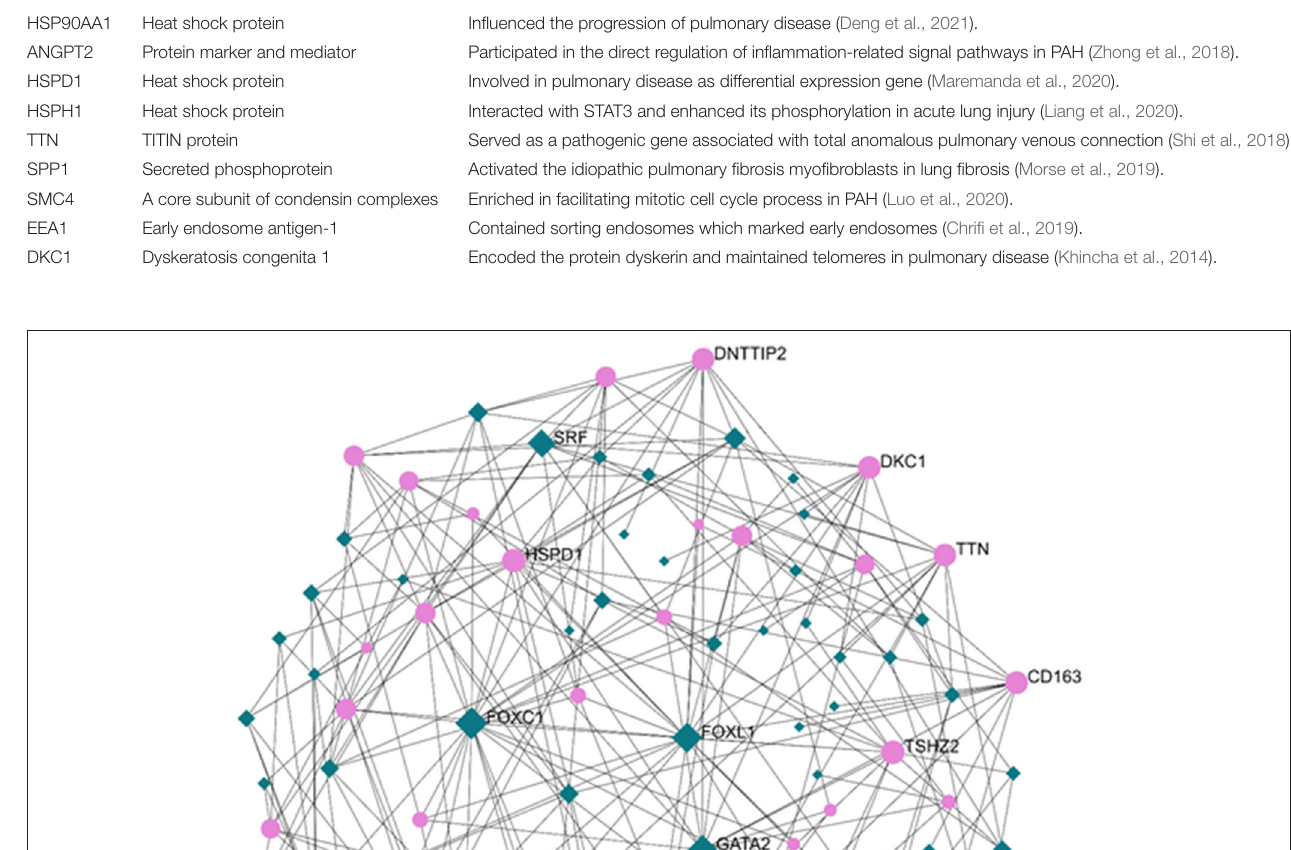
TABLE 3 | Summary of hub proteins identified from protein–protein interactions analysis of encoded differentially expressed genes in PAH disease.